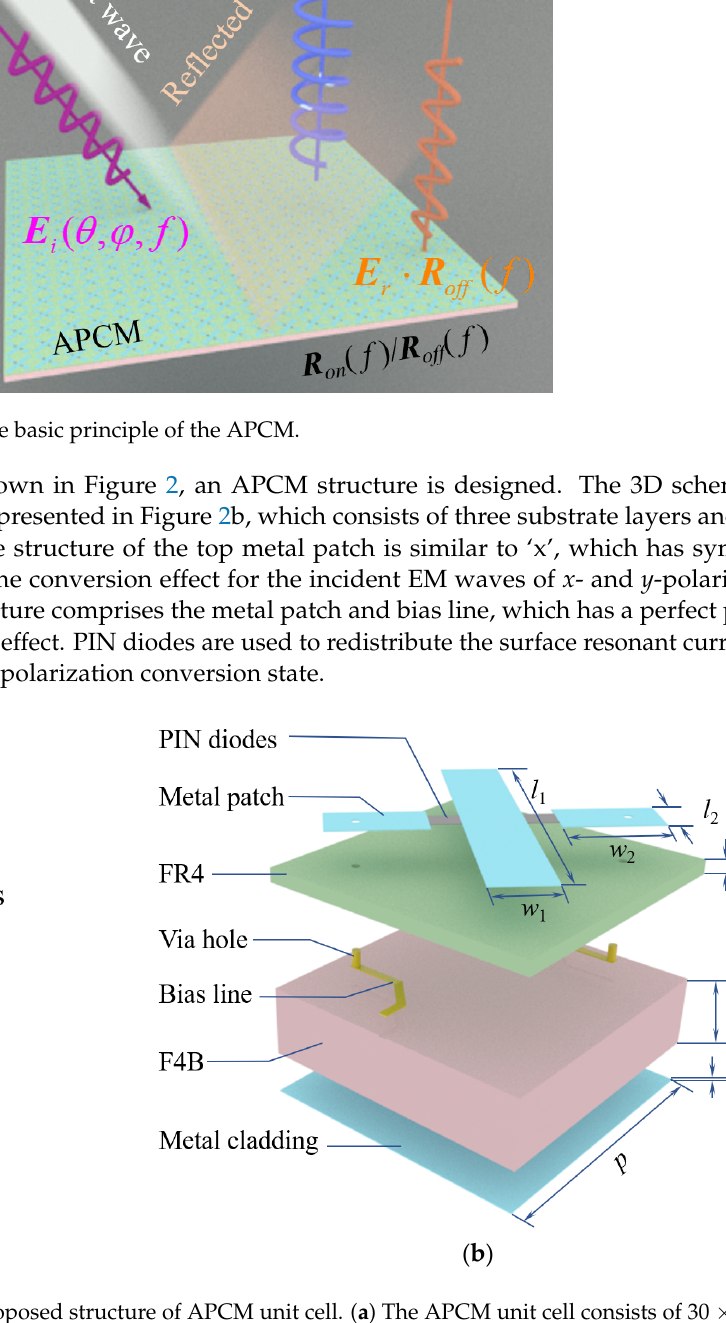
Figure 2. Proposed structure of APCM unit cell. ( a ) The APCM unit cell consists of 30 × 30-unit cells. ( b ) 3D schematic of the unit cell.